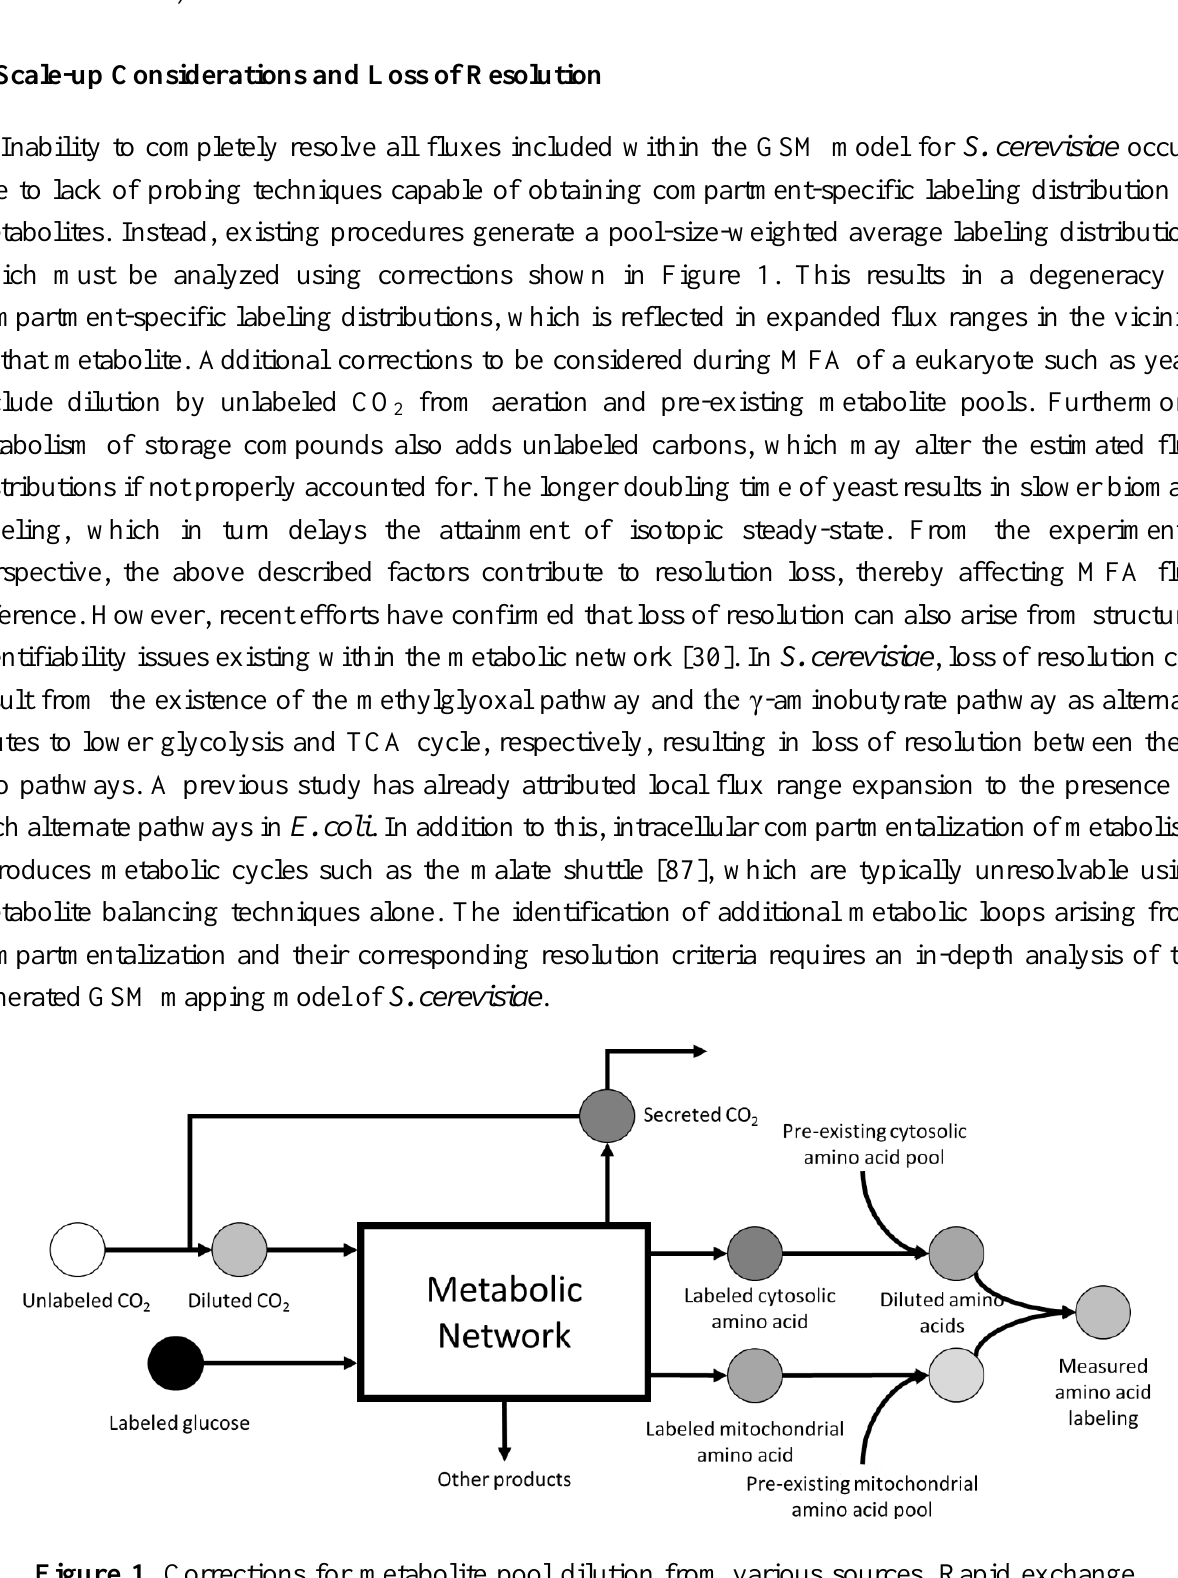
Figure 1. Corrections for metabolite pool dilution from various sources. Rapid exchange of intracellular and extracellular CO2 introduces unlabeled carbons into the metabolic network. Although its impact decreases with time, it still plays a significant role during mid-exponential phase [88]. Dilution of compartmental amino acid pools arises from pre-existing pools. The final measured labeling distribution is the average labeling across all compartmental